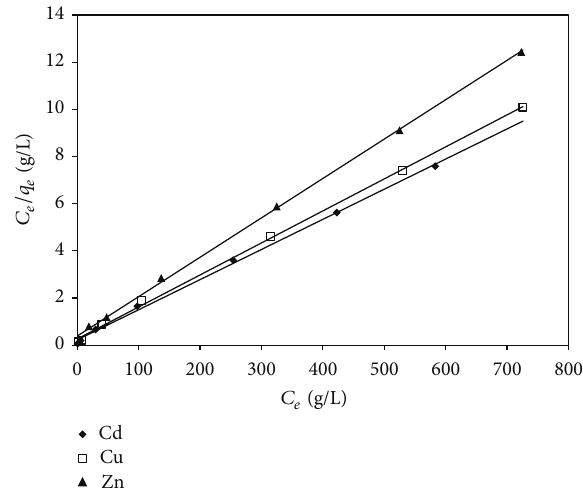
Figure 5: Langmuir plot for the adsorption of Cd (II), Cu (II), and Zn (II) onto Aminated Desmostachya bipinnata (ADBP).